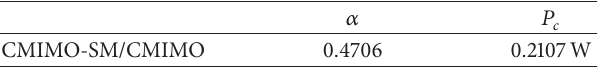
Table 4: 𝛼 , and 𝑃 𝑐 values for local communication using CMIMO- SM and CMIMO.